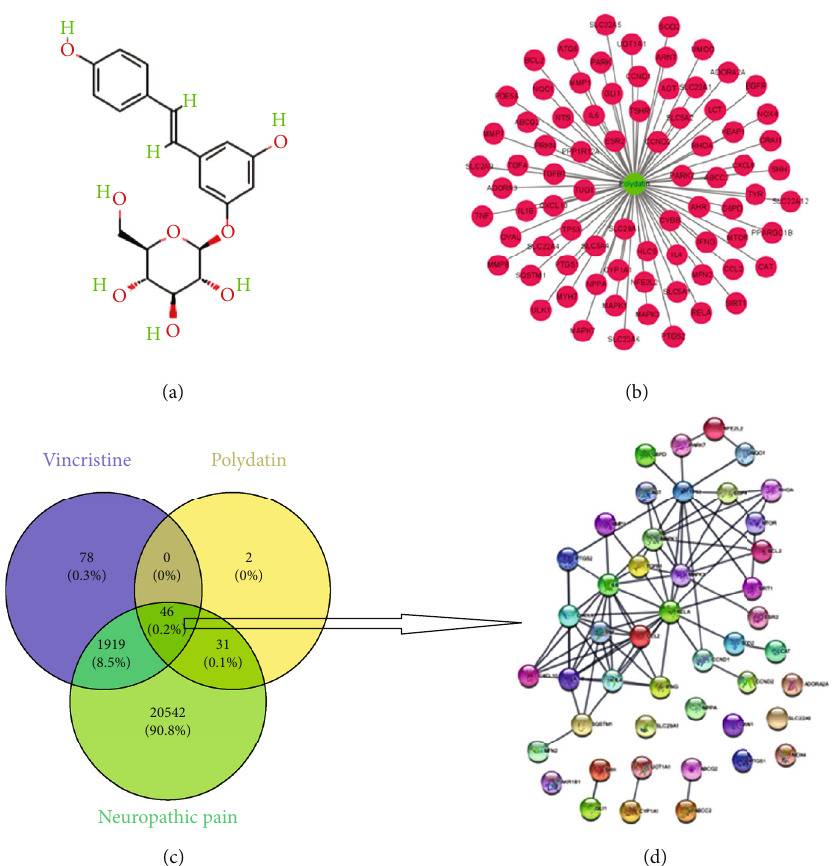
Figure 1: The potential targets of polydatin in the treatment of vincristine-induced neurotoxicity for screening pharmacology biotargets. (a) 2D chemical structure of polydatin. (b) The candidate targets of polydatin. (c) Venn diagram of 46 intersection targets. (d) PPI network of intersection genes generated by